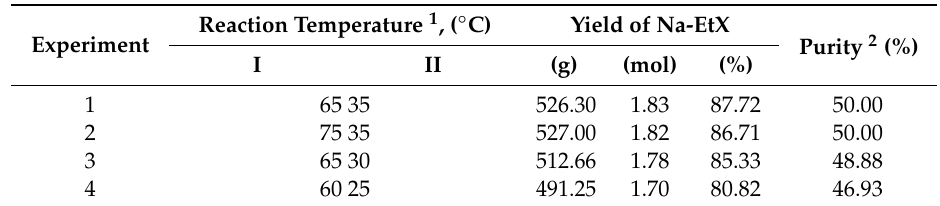
Table 2. Dependence of Na-EtX yield from temperature (reaction conditions: reaction time 4.5 h;